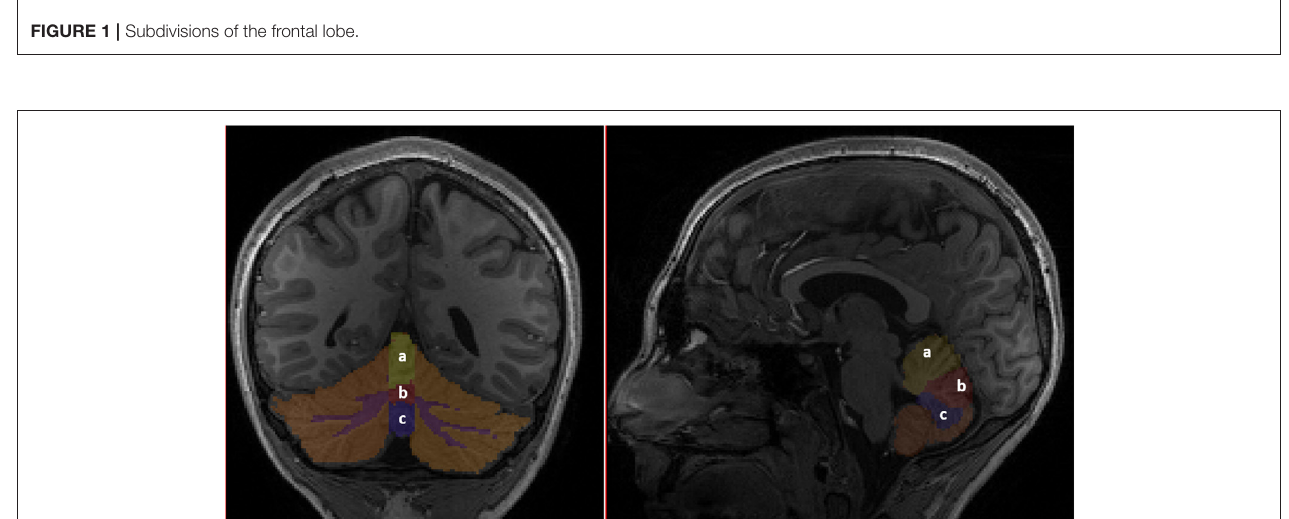
FIGURE 2 | Subdivisions of the cerebellum. (a) Superior vermis. (b) Middle vermis. (c) Inferior